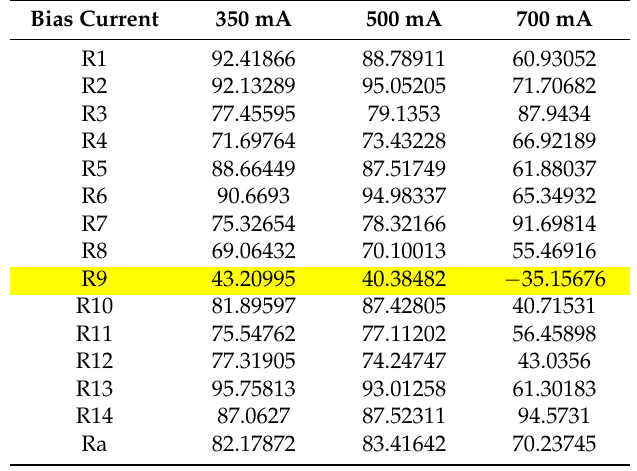
Table A1. The 14 CRI test colors of FC package QD/QW WLED according to DIN 6169 at the bias currents of 350, 500 and 700